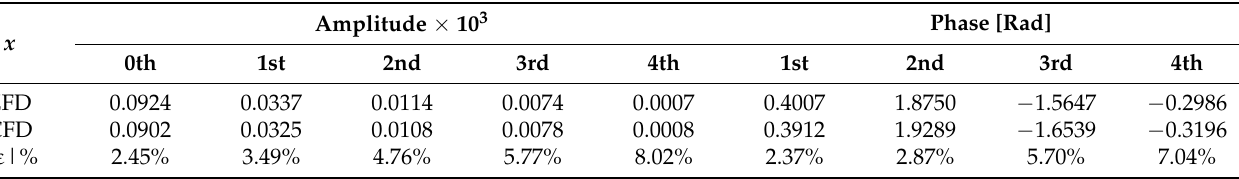
Table 5. Harmonic amplitudes and phases of surge ( x ) for the FRxz ϕθ head waves